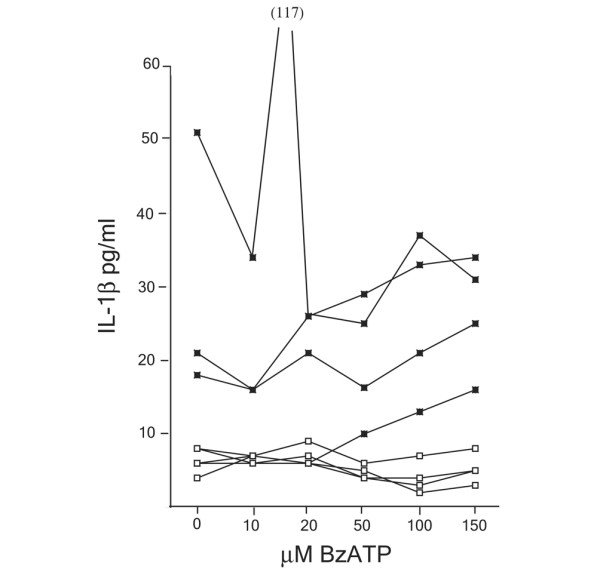
P2X7-stimulated secretion of IL-1β. Splenocytes were primed in vitro with lipopolysaccharide and were then stimulated with 2'-3'-O-(4-benzoylbenzoyl)-adenosine 5'-triphosphate (BzATP) as indicated. The graph shows IL-1β secretion by cells from New Zealand Black mice (open squares) and New Zealand White mice (filled squares). Each line represents IL-1β secretion by cells from a single mouse.